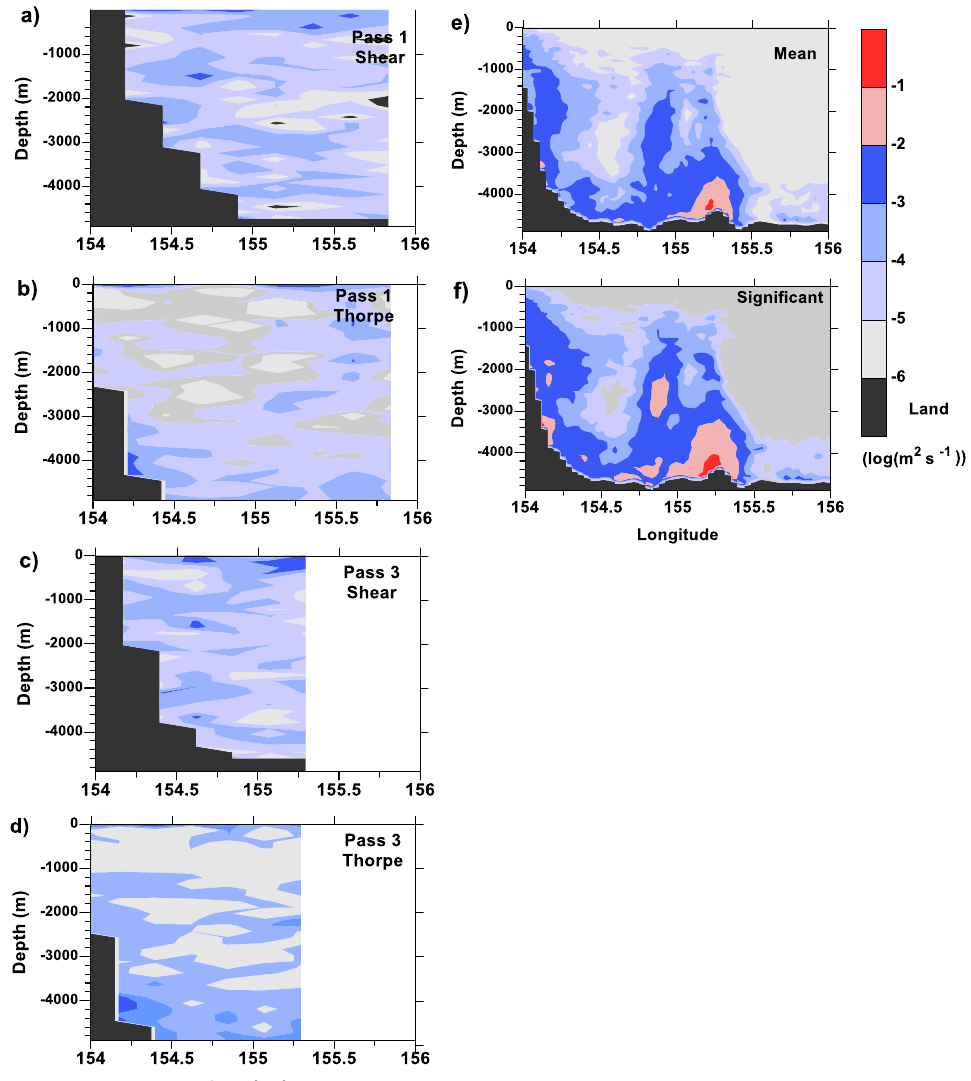
Fig. 15 Log of the estimate of the temperature diffusivity from the CTD/LADCP observations from the first pass by the mooring locations according to a shear formulation and b Thorpe displacement. The log of the c shear and d Thorpe estimates of the vertical temperature diffusivity for the third pass by the mooring locations. Log of the e mean and f significant vertical temperature diffusivity from the tidal simulation along the observational